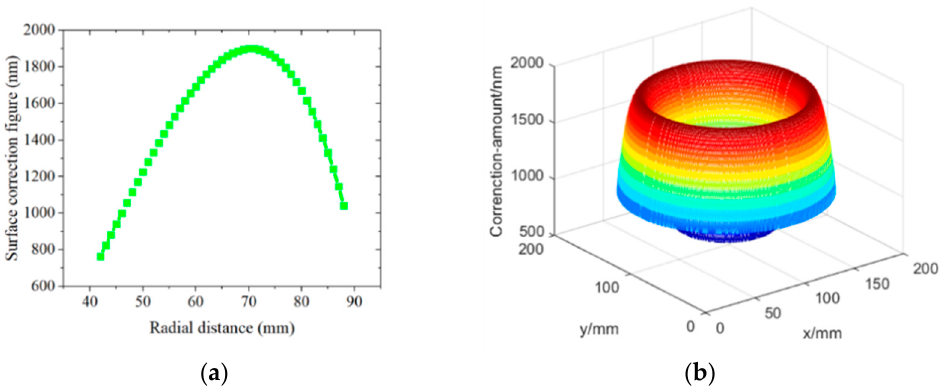
Figure 3. ( a ) The surface correction figure (R = 42–88 mm); ( b ) the correction-amount distribution.